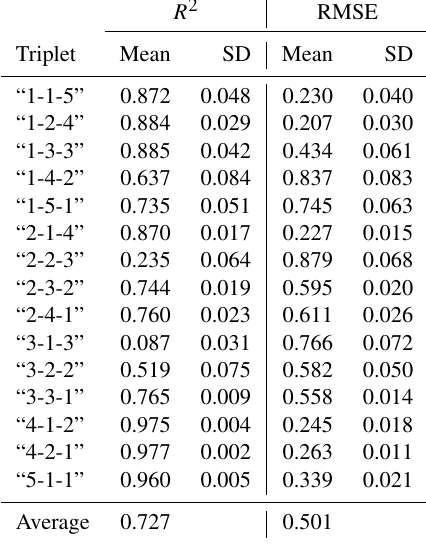
Table 2. Computed mean and standard deviation (SD) for R 2 and RMSE (ln (cmh − 1 )) values using the bootstrap method for the binned lineal regression of ln K sat against all possible (IE, triplet